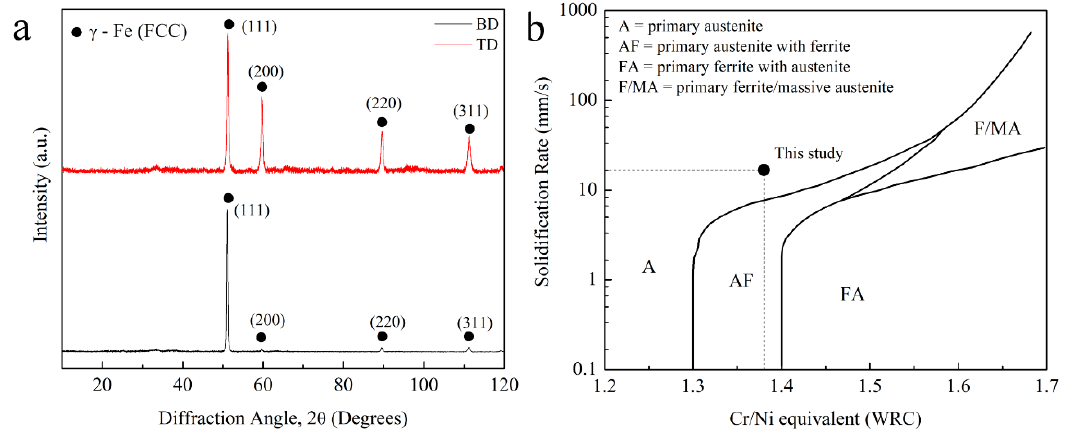
Figure 10. Representative XRD patterns of the 316LSS samples were produced using LPB A/SM ( a ). ( b ) Solidification map for austenitic stainless-steel welds [61].